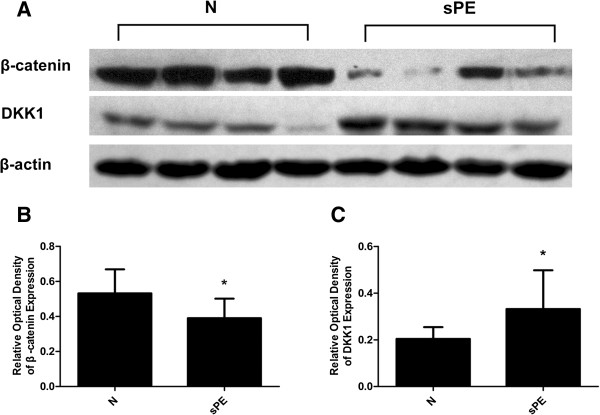
The expression of β-catenin and DKK1 proteins in normal and severe preeclampsia group. Figure 
5A: Representative examples of β-catenin and DKK1 in placentas from normal control group (N) and severe preeclampsia group (sPE). The bar graph (B) and (C) shows the relative optical density of β-catenin and DKK1 expression, respectively. The β-catenin expression was significantly decreased, whereas the DKK1 was significantly increased in sPE group compared with the control group. (Data are presented mean ± SD, n=20 for each group, *p < 0.05, respectively).